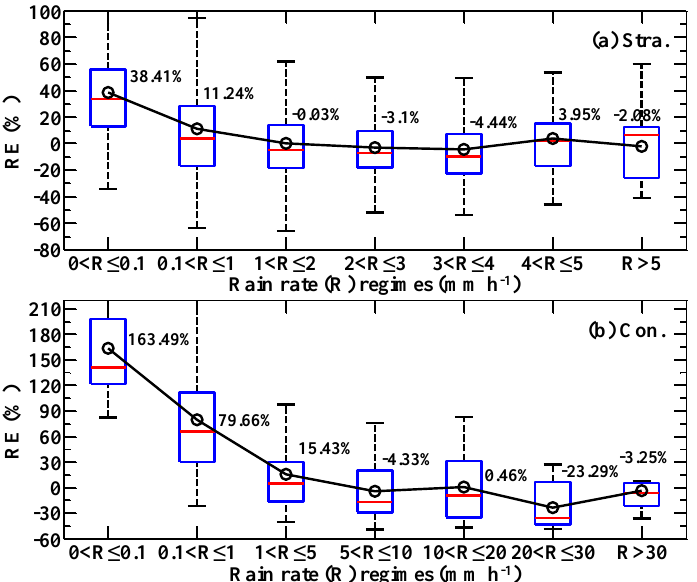
Figure 15. Relative errors (REs) of the relationship-derived compared to the observed rain rates (Rs) in different regimes for stratiform ( a ) and convective ( b ) rains. The black lines with circles and black-font values both represent the averages.